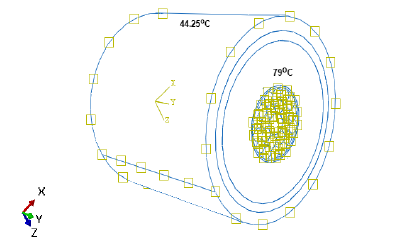
Figure 4. Thermal loading